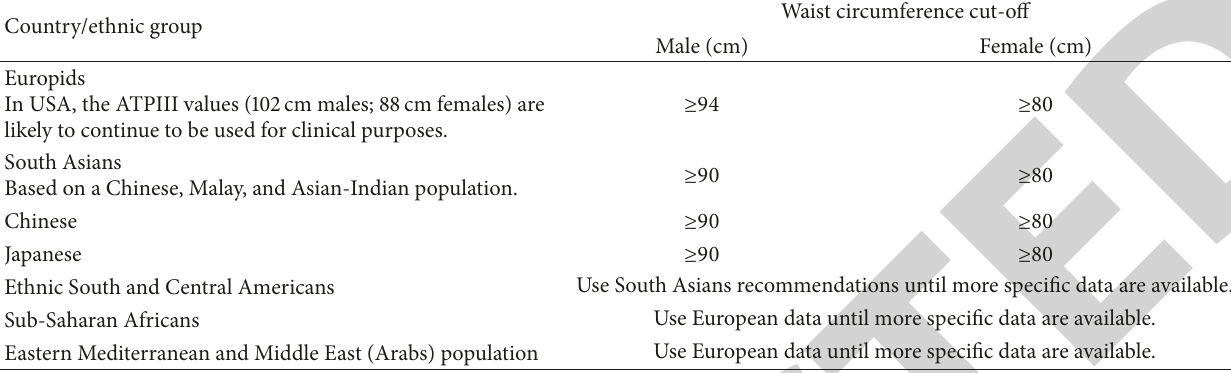
Table 2: Gender and age-specific waist circumference cut-offs [1]. Country/ethnic